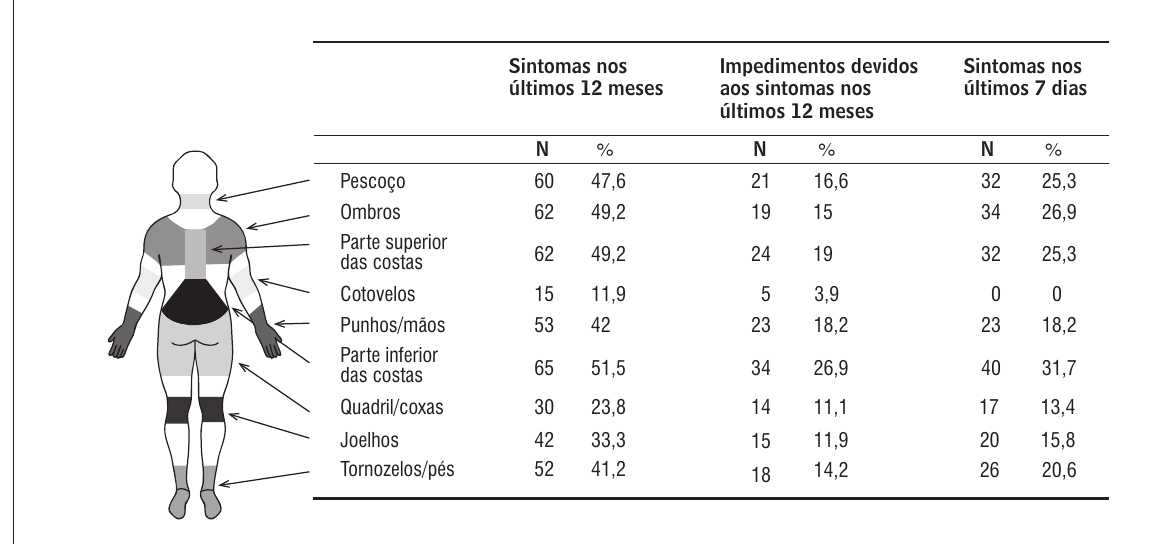
Figura 1 - Sintomas osteomusculares e impedimento para realizar atividades diárias Fonte: Dados da